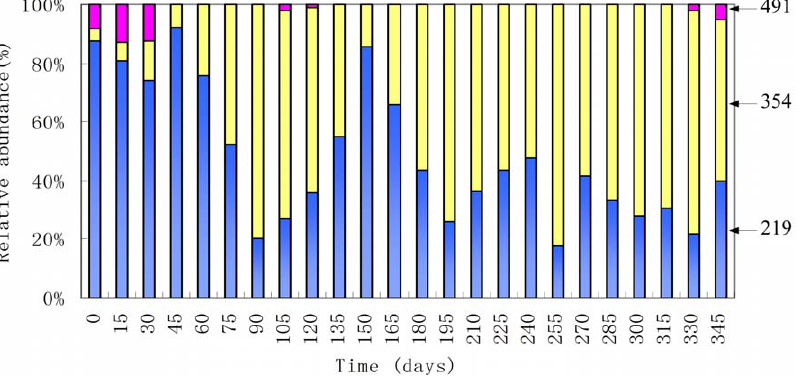
Figure 2. Histograms of T-RF relative abundances in the system for Taq I T-RFLP profiles. The relative abundance is the ratio of the peak area of a given T-RF in a given sample to the sum of all T-RFs in that sample expressed as a percentage. Arrows indicate the sizes of the restriction fragments for the abundant T-RFs in base pairs.